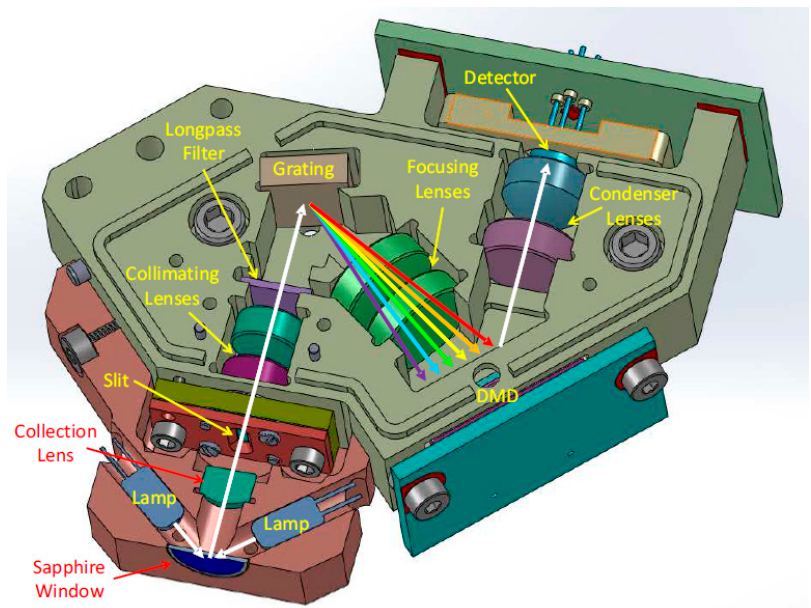
Figure 5. Interior view of the DLP NIRscan Nano-optical architecture. Table 2. NIRscan Nano EVM design specifications.